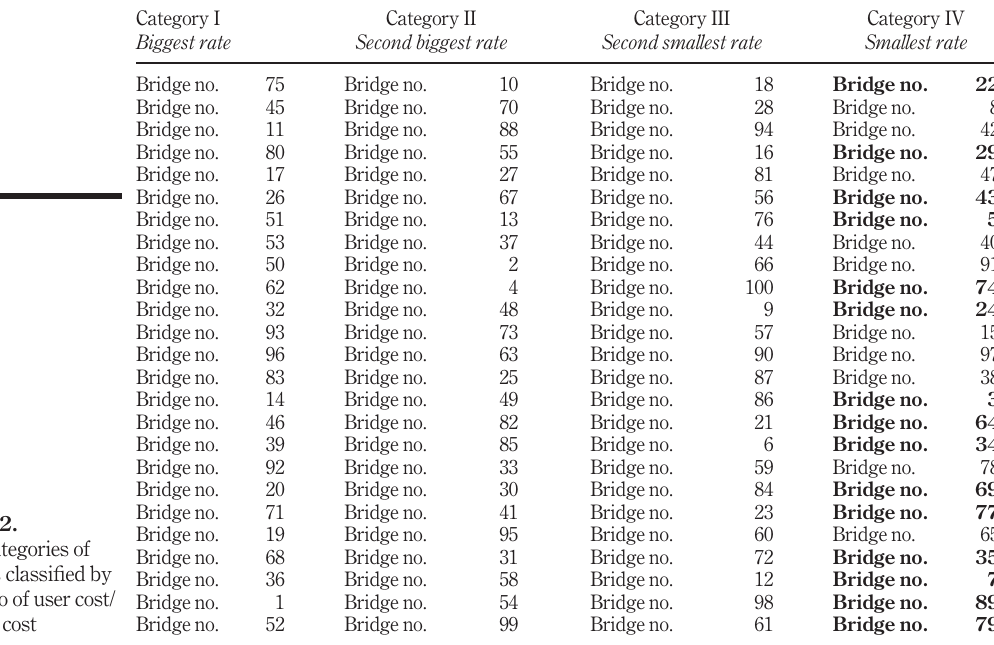
Table 2. Four categories of bridges classi fi ed by the ratio of user cost/ agency cost